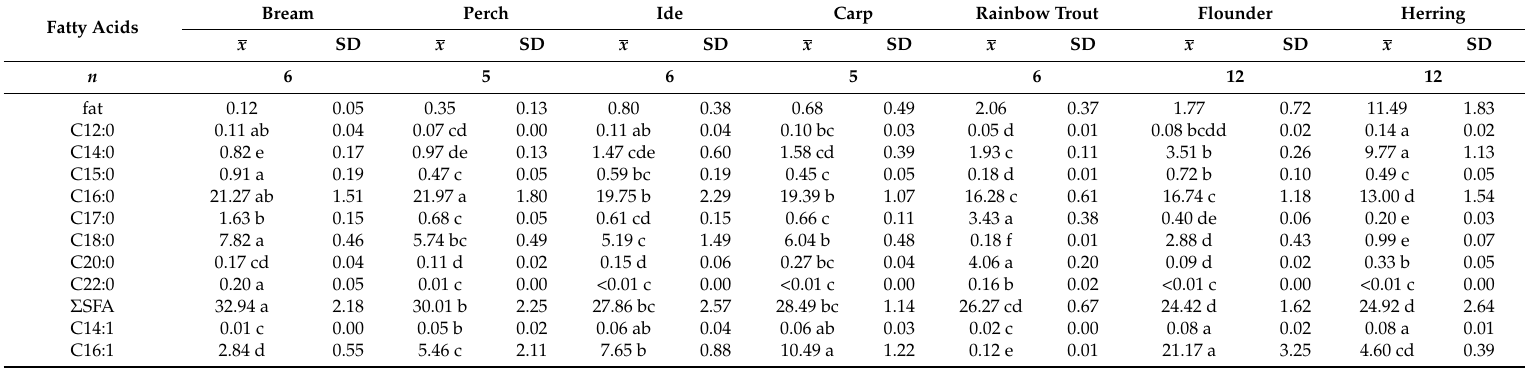
Table 2. Lipid content (%) and fatty acids composition (% of total fatty acids) in muscles of different fish